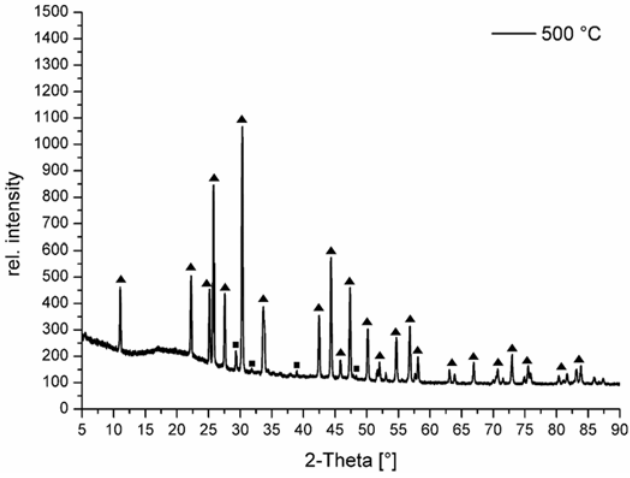
Figure 10. XRD pattern of the supporting material La 2 O 3 –ZnO calcined at 500 °C with phases of lanthanum oxide-carbonate (triangle) and sodium nitrate (box).